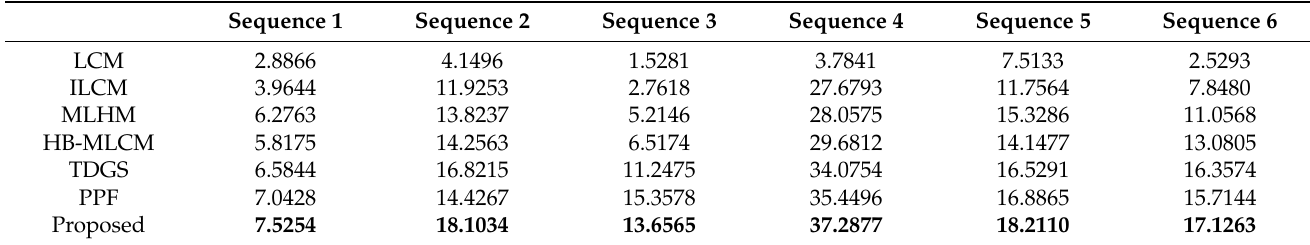
Table 1. The comparisons of SCRG under different backgrounds.